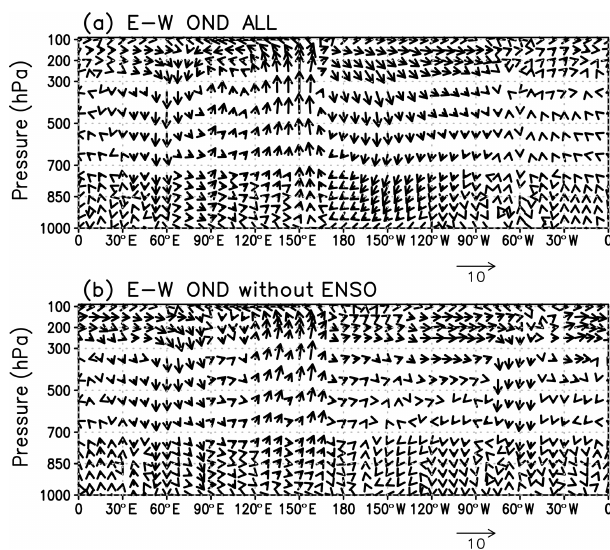
Figure 5. (a) October–November–December (OND) mean zonal- pressure circulation ([ U ] wind and minus p velocity) differences averaged from 10 ◦ S to 10 ◦ N between EQBO and WQBO winters. (b) Same as panel (a) but without ENSO winters. Arrows below the figure show the scales for 10ms − 1 [ U ] wind. p velocity is multi- plied by 300.